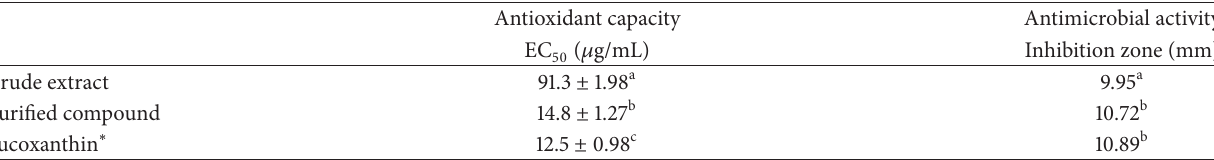
Table 1: Antioxidant and antimicrobial activities of standard ∗ , crude extract, and purified compound from H. elongata seaweed. Antioxidant capacity